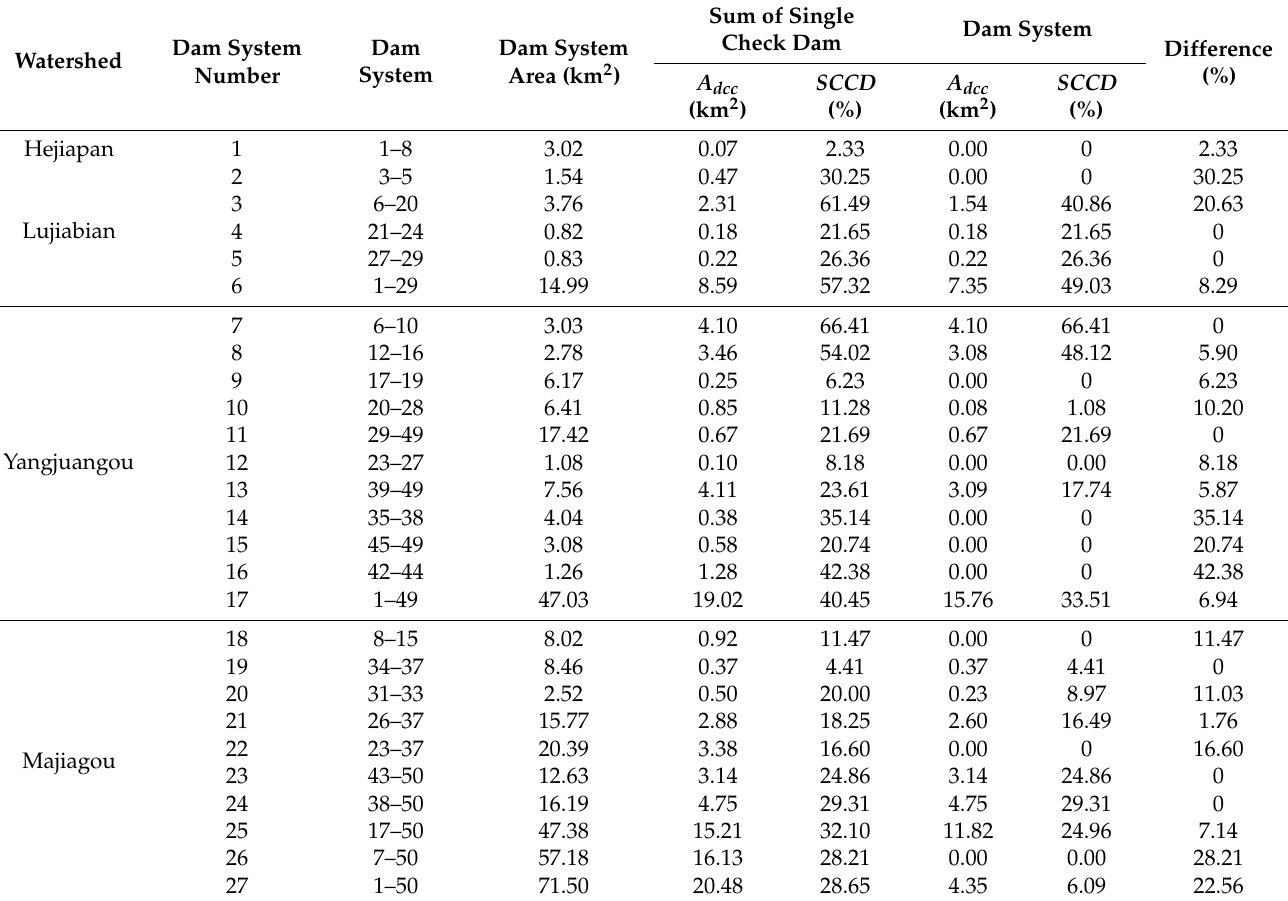
Table 3. SCCD of the sum of a single check dam and dam system in the four watersheds.